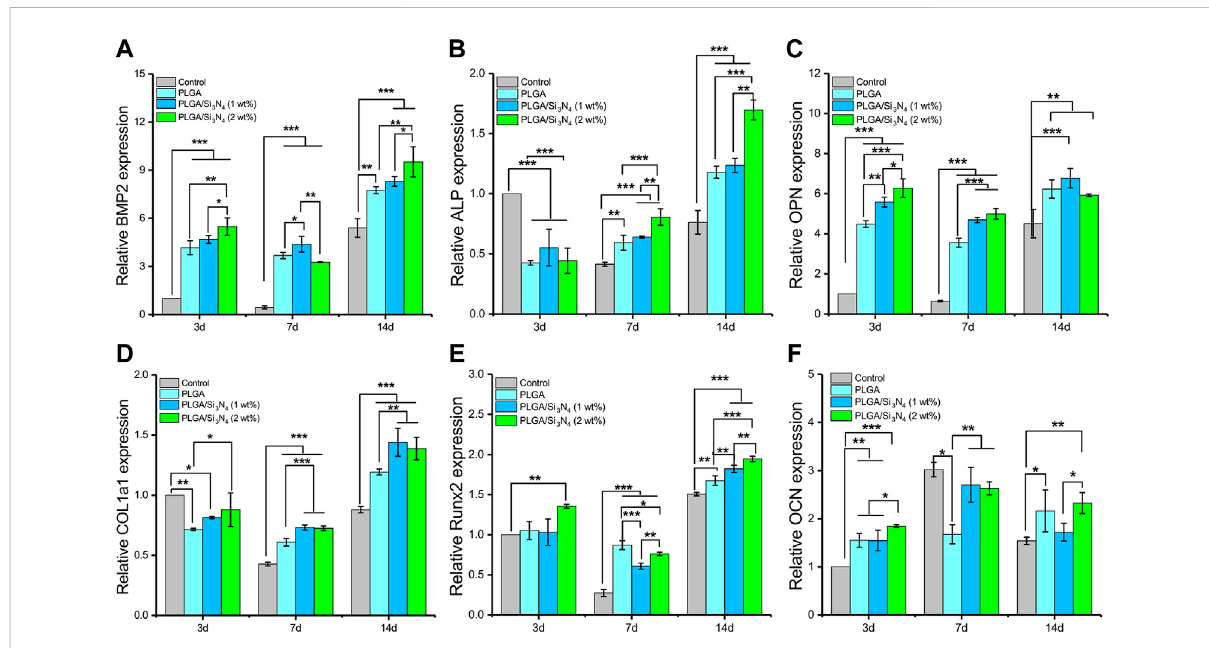
FIGURE 4 Gene expression of MSCs cultured on the PLGA nano fi ber scaffold, PLGA/Si 3 N 4 (1 wt.%) nano fi ber scaffold, and PLGA/Si 3 N 4 (2 wt.%) nano fi ber scaffold for 3, 7, and 14 days. (A) BMP2 expression. (B) ALP expression. (C) OPN expression. (D) COL1a1 expression. (E) Runx2 expression. (F) OCN